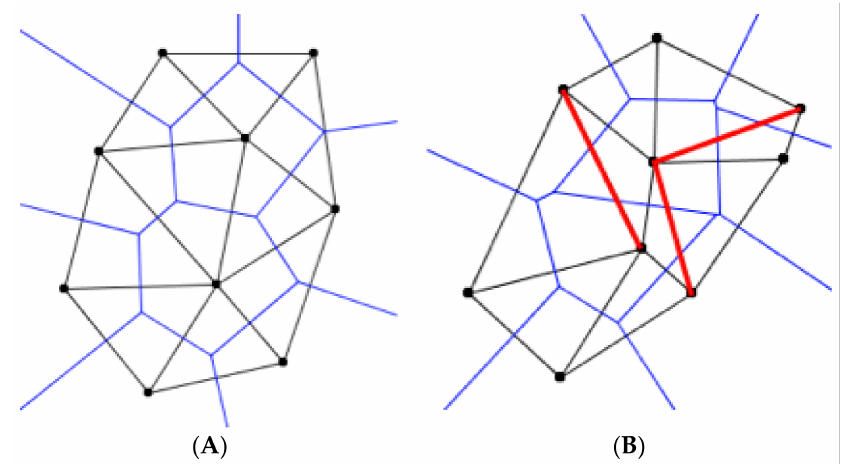
Figure 17. ( A ) A Delaunay dual superimposed upon a Voronoi tessellation where the Pitteway triangulation condition is satisfied, i.e., each edge of the Delaunay dual crosses one and only one edge of the Voronoi tessellation. In this picture, the polygonal cells have a more general shape in that most of the interior angles are not too different from a mean of the interior angles. In such cases, biological investigators infer stability of the epithelia. ( B ) Pitteway violations are shown in red on this Delaunay dual superimposed upon a Voronoi tessellation, i.e., each of the red edges of the Delaunay dual crosses more than one edge of the Voronoi tessellation. In this picture the polygonal cells have a less general shape in that several of the interior angles are very different from a mean of the interior angles. In such cases, investigators infer that the irregularity of the above cells in the epithelia cause the Pitteway violation in which cases biological and geographic investigators [40] have used the presence of such violations to infer that such cell packings are less